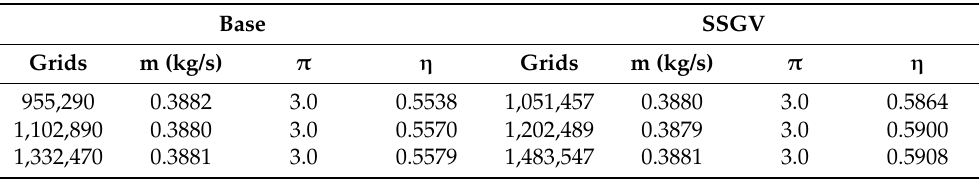
Table 3. Grid independent verification .